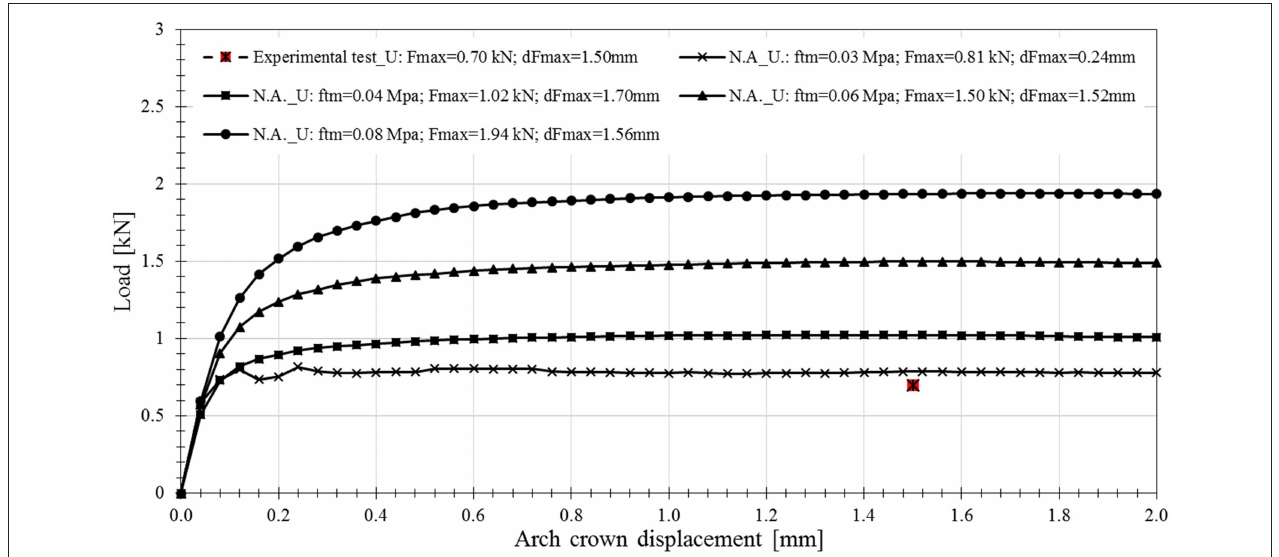
FIGURE 5 | Numerical Load—Arch crown displacement curves for the unstrengthened